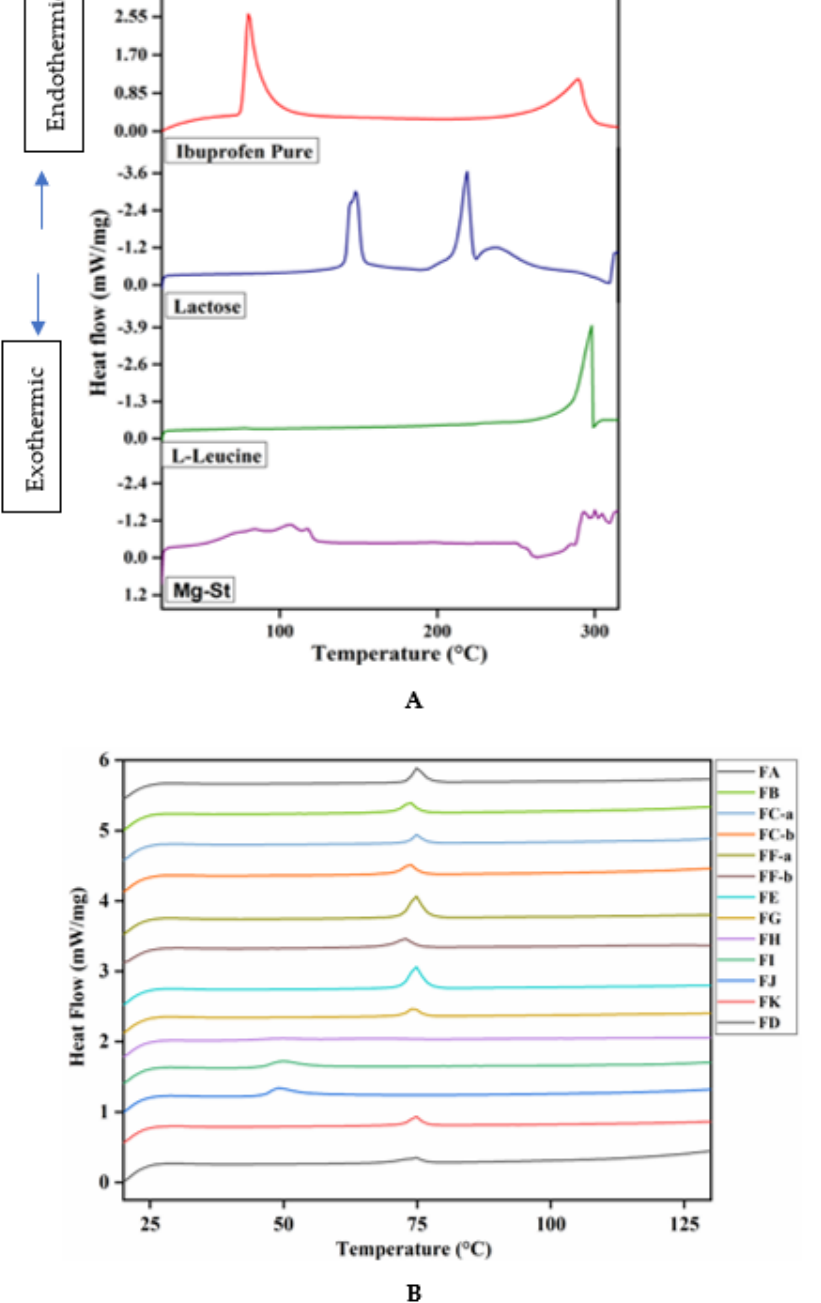
Figure 5. ( A ) Stacked DSC thermograms of original IBF, lactose, leucine, and MgSt. ( B ) Prepared DPI formulation mixtures. (Mean ± SD, n = 3). formulation mixtures. (Mean ± SD, n =